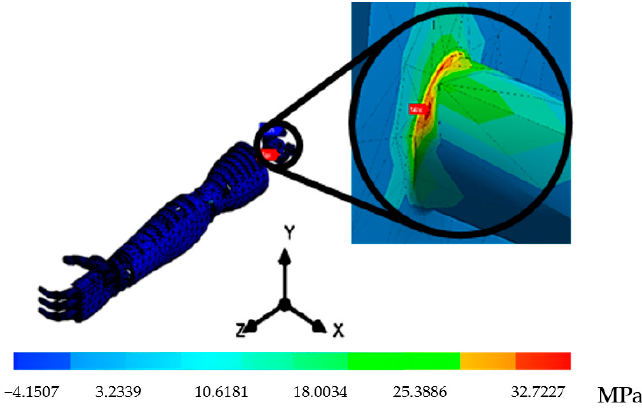
Figure 5. The total displacement, material aluminum 7075-O.